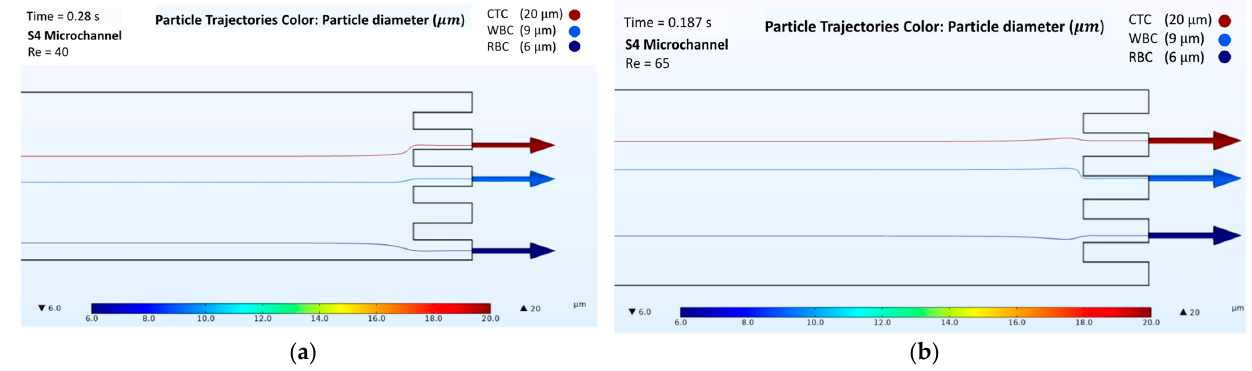
Figure 6. Numerical results of the cell separation study in the S4 microchannel. CTC, WBC, and RBC cells are represented by dark red, light blue, and dark blue colors, respectively: ( a ) Cell distribution at the outlet of the S4 microchannel at a Reynolds number of 40; ( b ) Cell distribution at the outlet of the S4 microchannel at a Reynolds number of